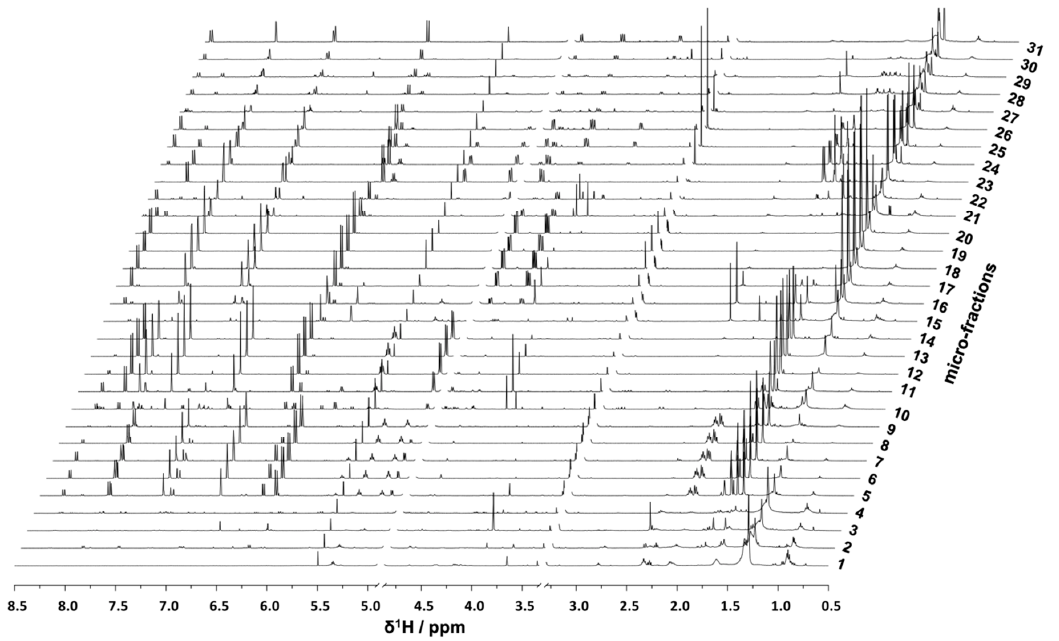
Figure 1. Stack Plot of PO01_01–PO01_31; 1 H NMR data ( δ H 0.5–8.5) of obtained Peucedanum ostruthium microfractions after fractionation with high-performance counter-current chromatographic (HPCCC). For clarity reasons, both, the water signal (at 4.9 ppm) and the signal of the solvent (at 3.31 ppm) are not shown.